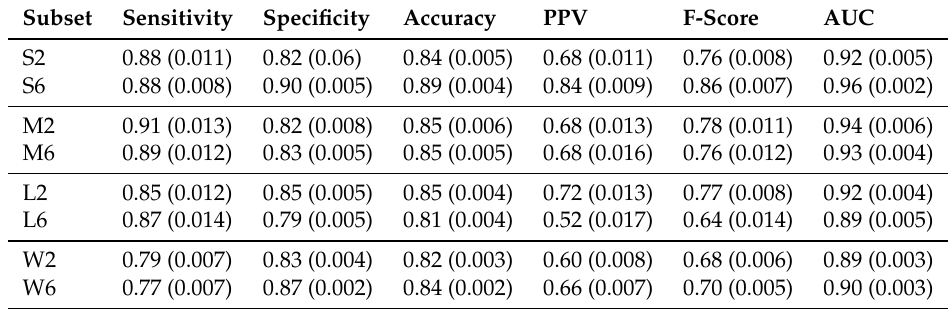
Table A4. Predictive performance of support vector machine based on the estimated sensitivity, specificity, accuracy, positive predictive value (PPV), F-score and the area under receiver operating characteristic curve (AUC) for two-week and six-week restriction period among the cows in early (S), mid (M) and late (L) lactation stage using cross validation studies.